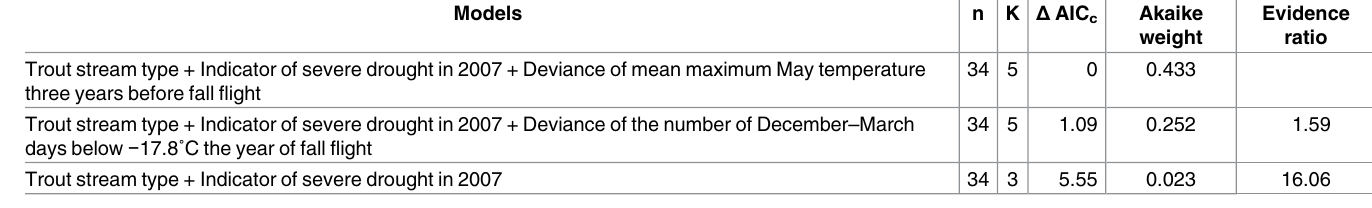
Table 3. Weather models for beaver colony density on streamswhere no targeted beaver management occurred on the Chequamegon side of the Chequamegon-Nicolet National Forest, 1997–2013. Models listed are the minimumAIC model, competitive models (those models within 2 AC units of the 006Dinimum), and the 2007 drought model. The evidenceratio is the ratio of the Akaike weights for the minimum AIC model and an alternate